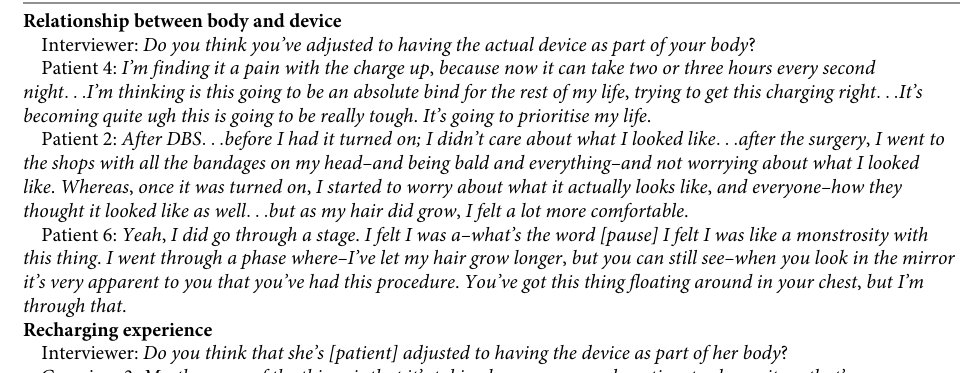
Table 4. Device acceptability and